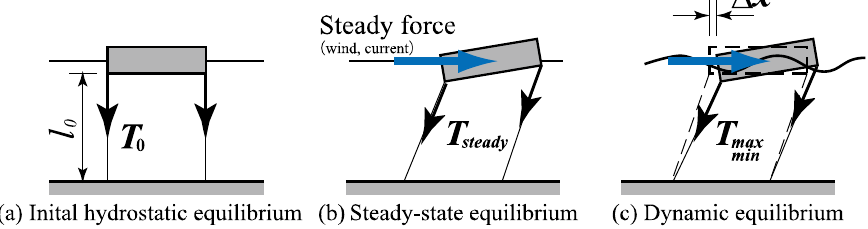
Fig. 3 Definition of tendon tension at each equilibrium state.